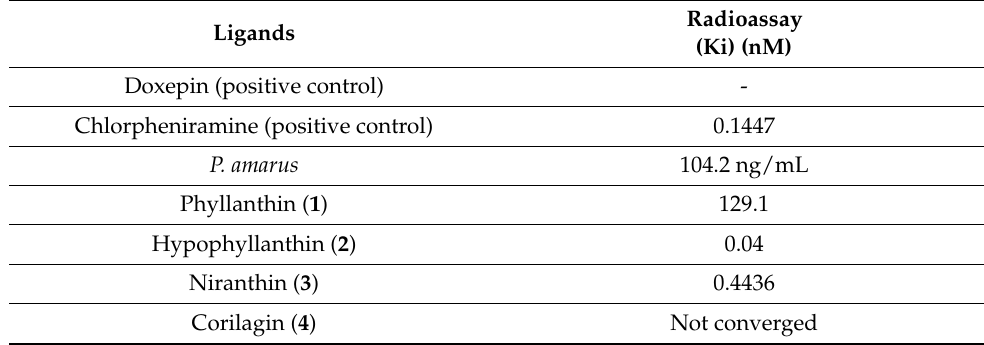
Table 8. Radioligand binding activity of P. amarus extract and its